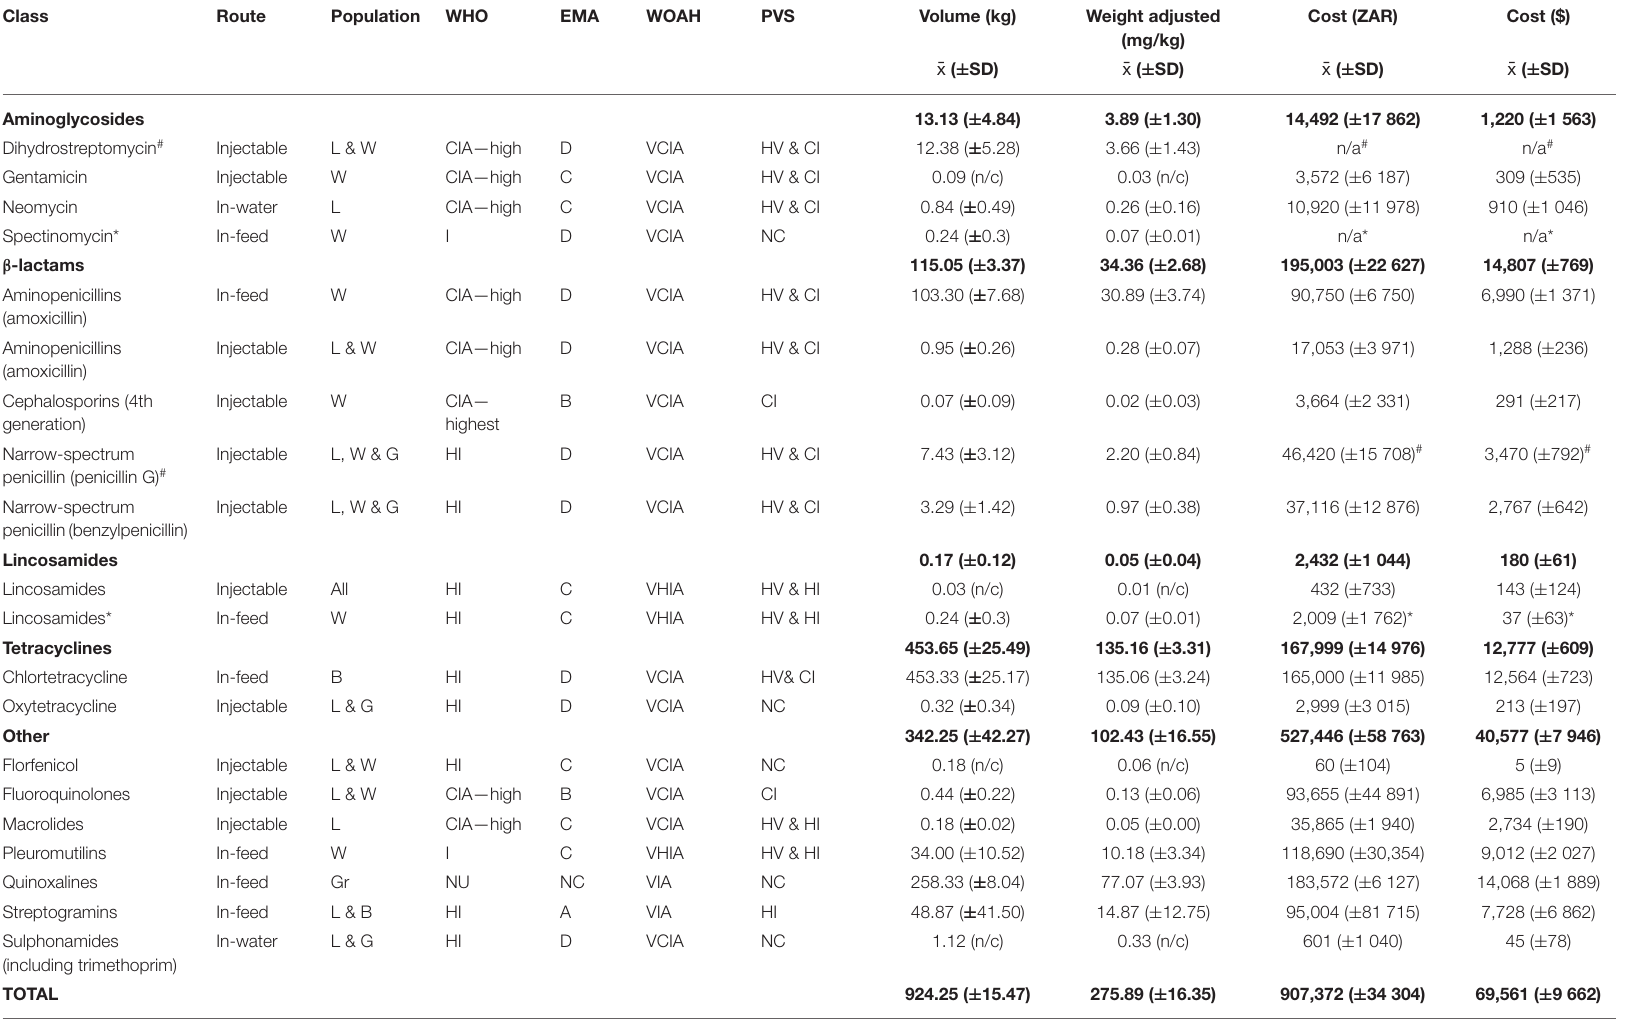
TABLE 2 | Average antibiotic usage in a commercial pig farm in South Africa over a three-year period (2016–2018) according to antibiotic class, route of administration, the targeted pig population and classification of